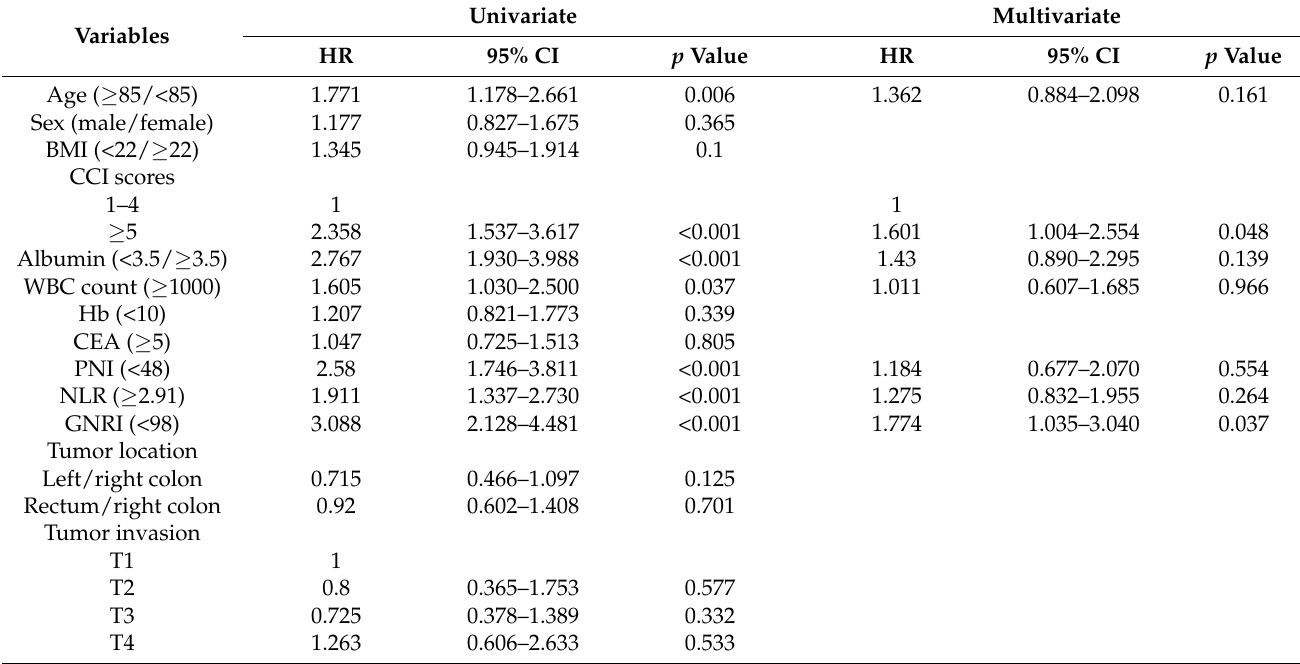
Table 4. Univariate and multivariate logistic regression analyses of the risk factors associated with CD grade ≥ 2 complica- tions in patients with CRC undergoing a curative